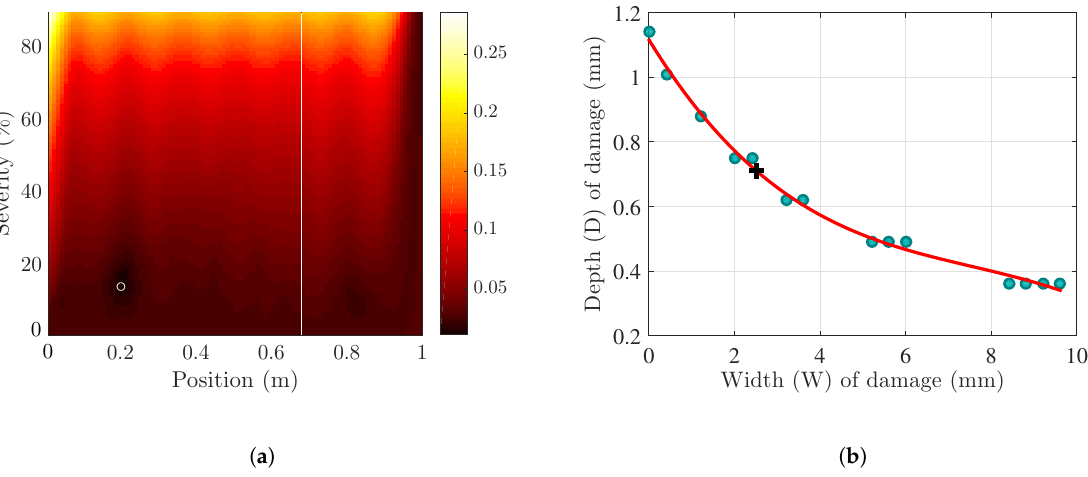
Figure 14. ( a ) FSC as a function of damage position and severity for damage described in Figure 13a; the white circle indicates that the damage position and severity are 0.20 m and 14.37%, respectively; ( b ) width and depth are extracted for 14.37% severity from the damage library (blue dots: raw extraction, red line: cubic fit, black cross: recovered